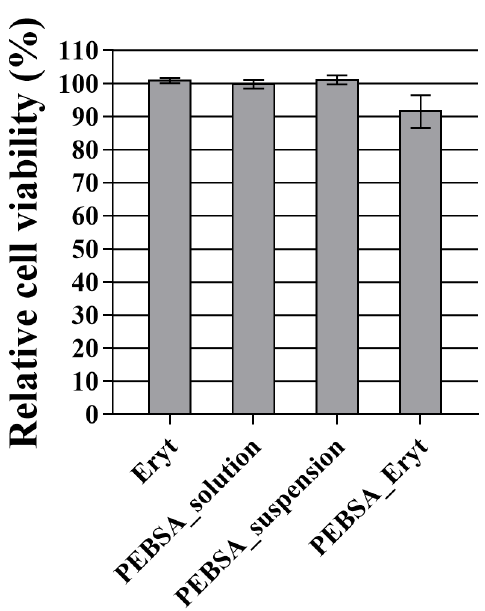
Figure 12. Cytotoxicity of HGF cells that were under treatment for 24 h with the tested compounds. The results are presented as a mean value ± the standard error of the mean (S.E.M.), n = 5; the dif ‐ ferences were not statistically significant.